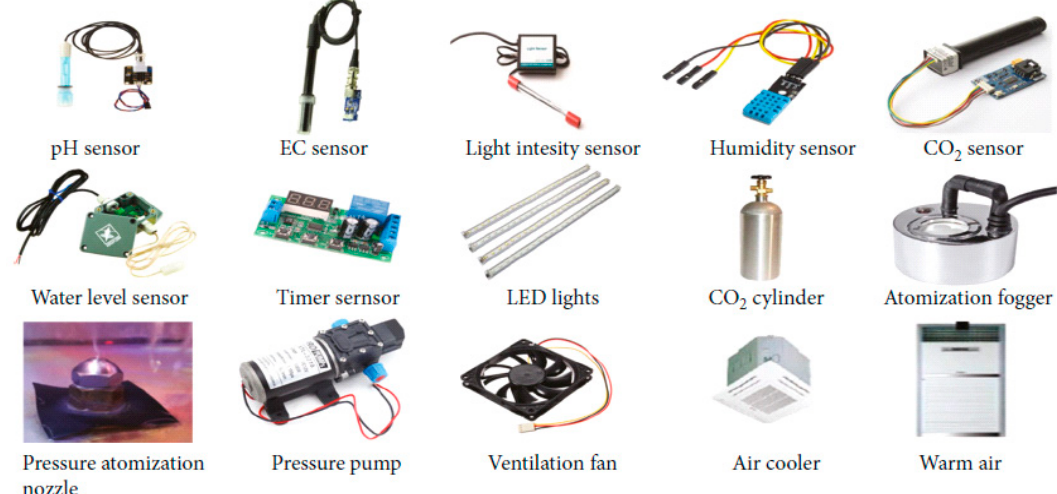
Figure 8. Sensors and actuators types utilized in the smart farming. Reprinted from ref. [21].